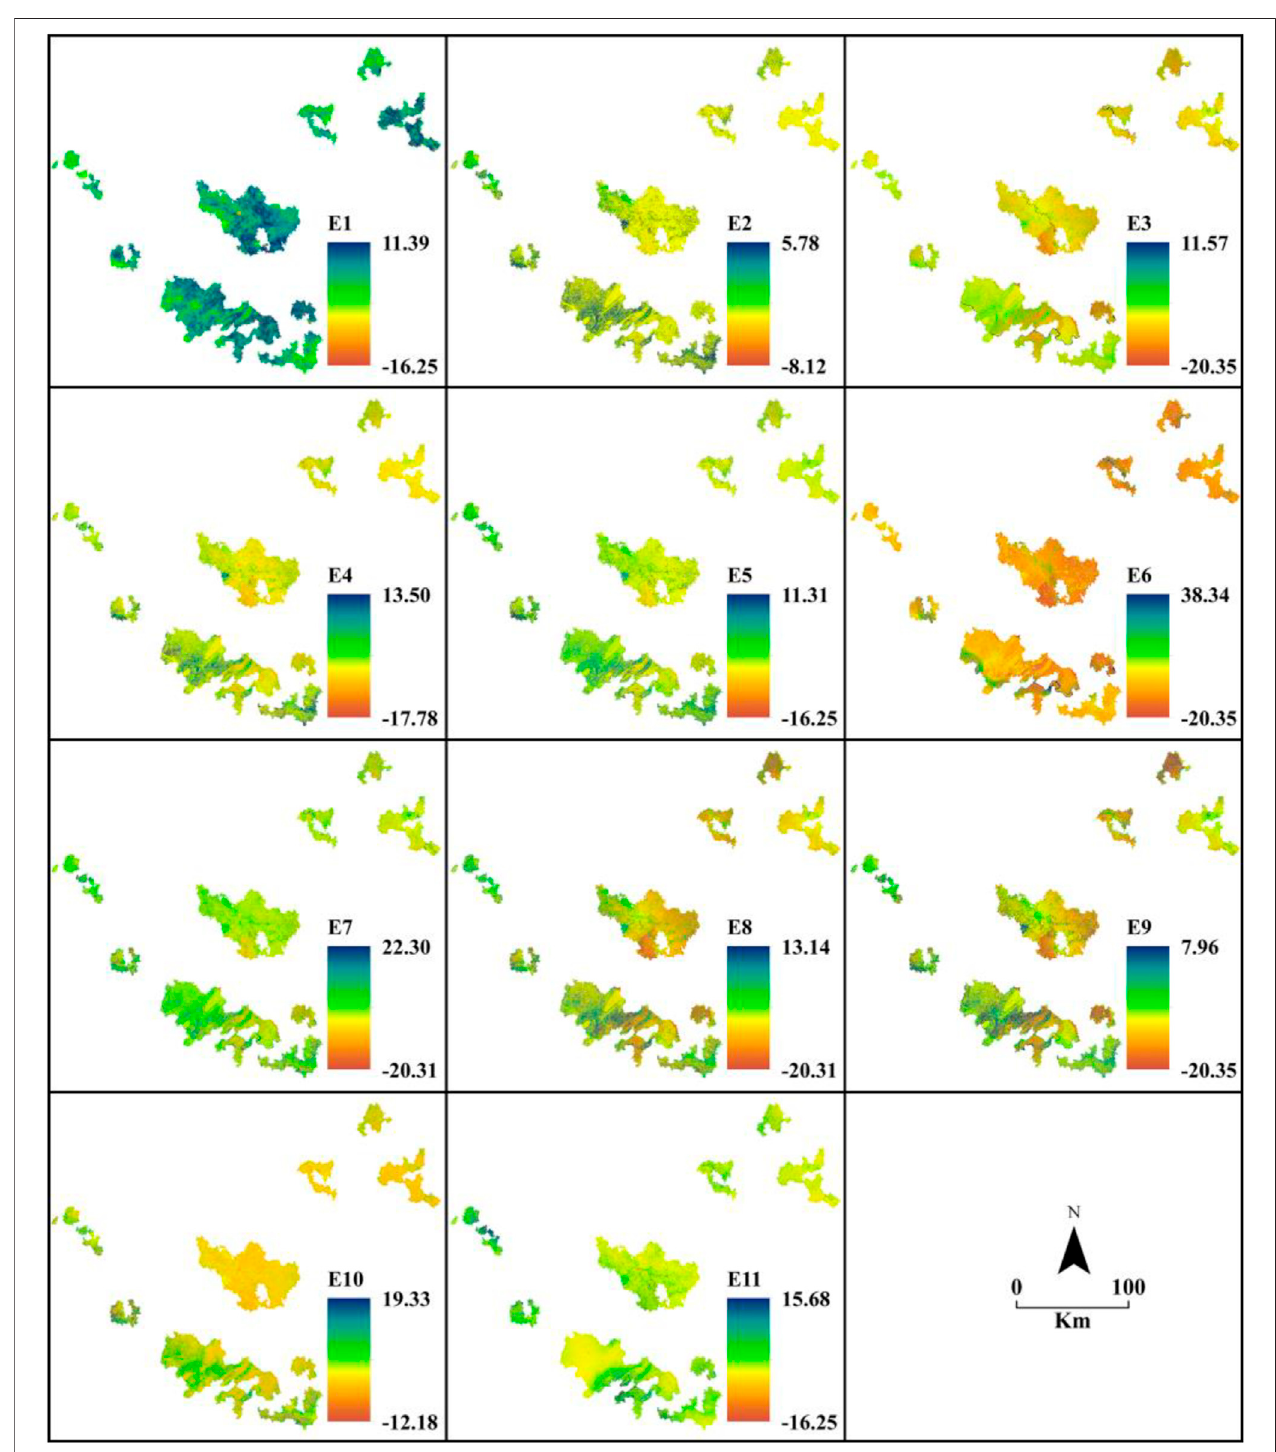
FIGURE 5 | Supply and demand balance index of ecosystem service (ESBI) of 11 ecosystem services in typical hilly areas, SW China. Food (E1), materials (E2), water(E3),airqualityregulation(E4),climateregulation(E5),waterpuri fi cation(E6),regulationofwater fl ows(E7),erosionprevention(E8),maintenanceofsoilfertility(E9), habitat services (E10), cultural and amenity services (E11).